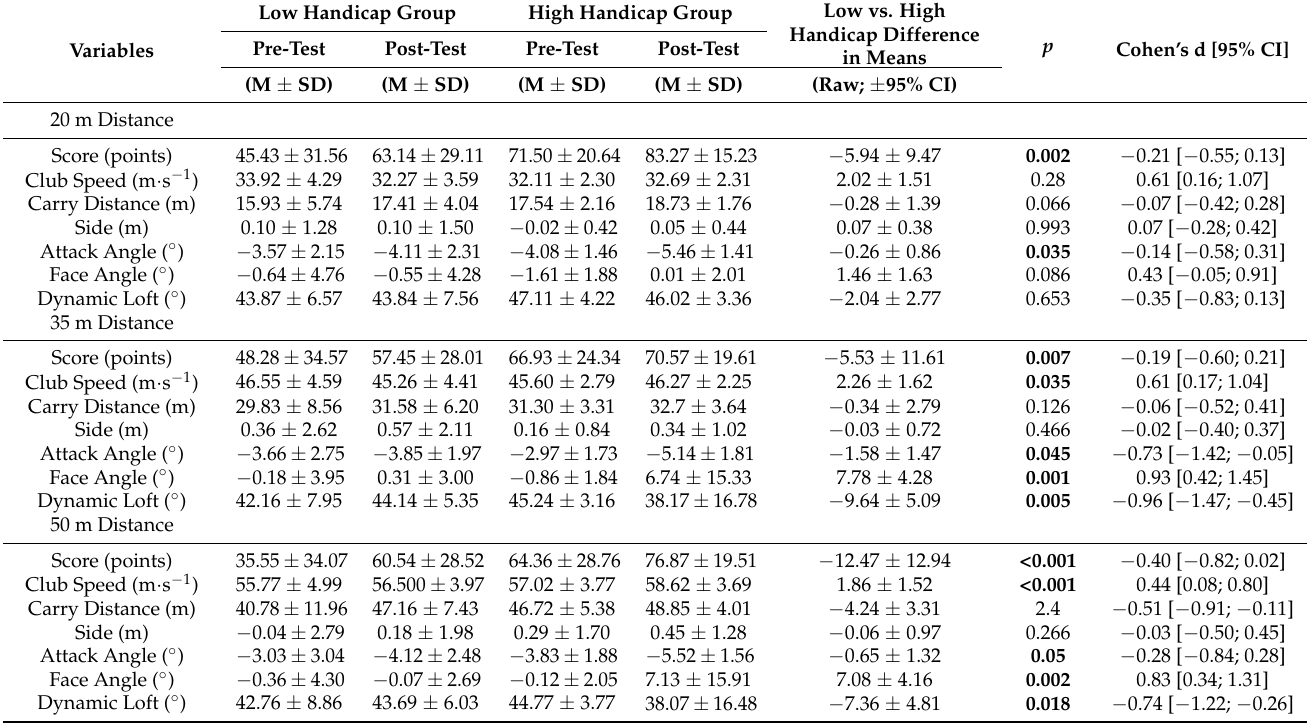
Table 4. Descriptive (M ± SD; Raw; ± 95% CI) and inferential results for the golf shot performance differentiated by the low and high handicap group within the DL group.